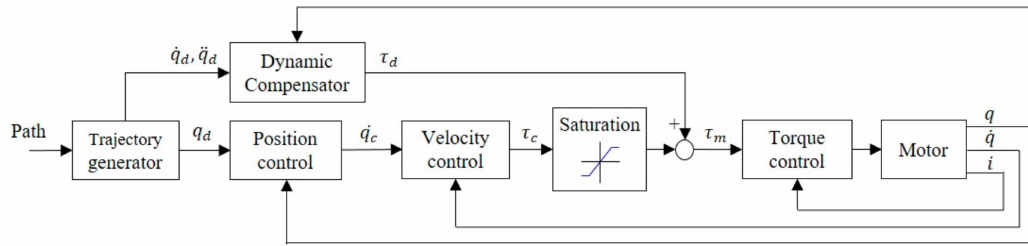
Figure 9. Real-time sti ff ness control